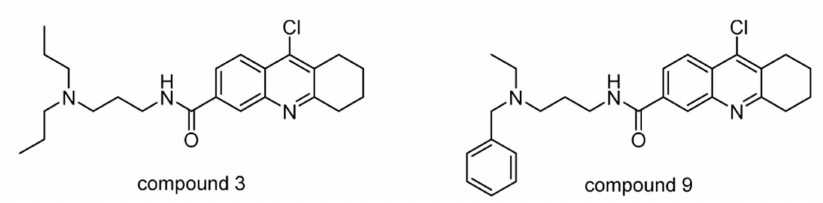
Figure 17. Structures of reported USP7/10